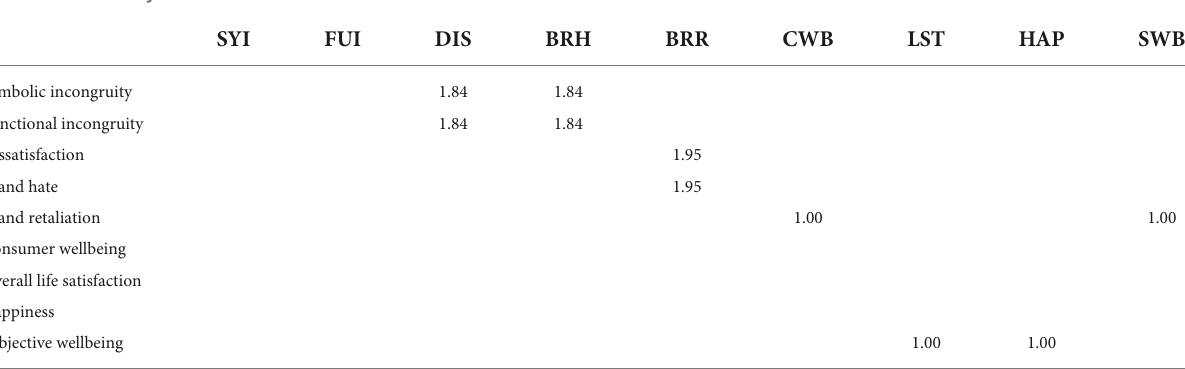
TABLE 4 Collinearity test.